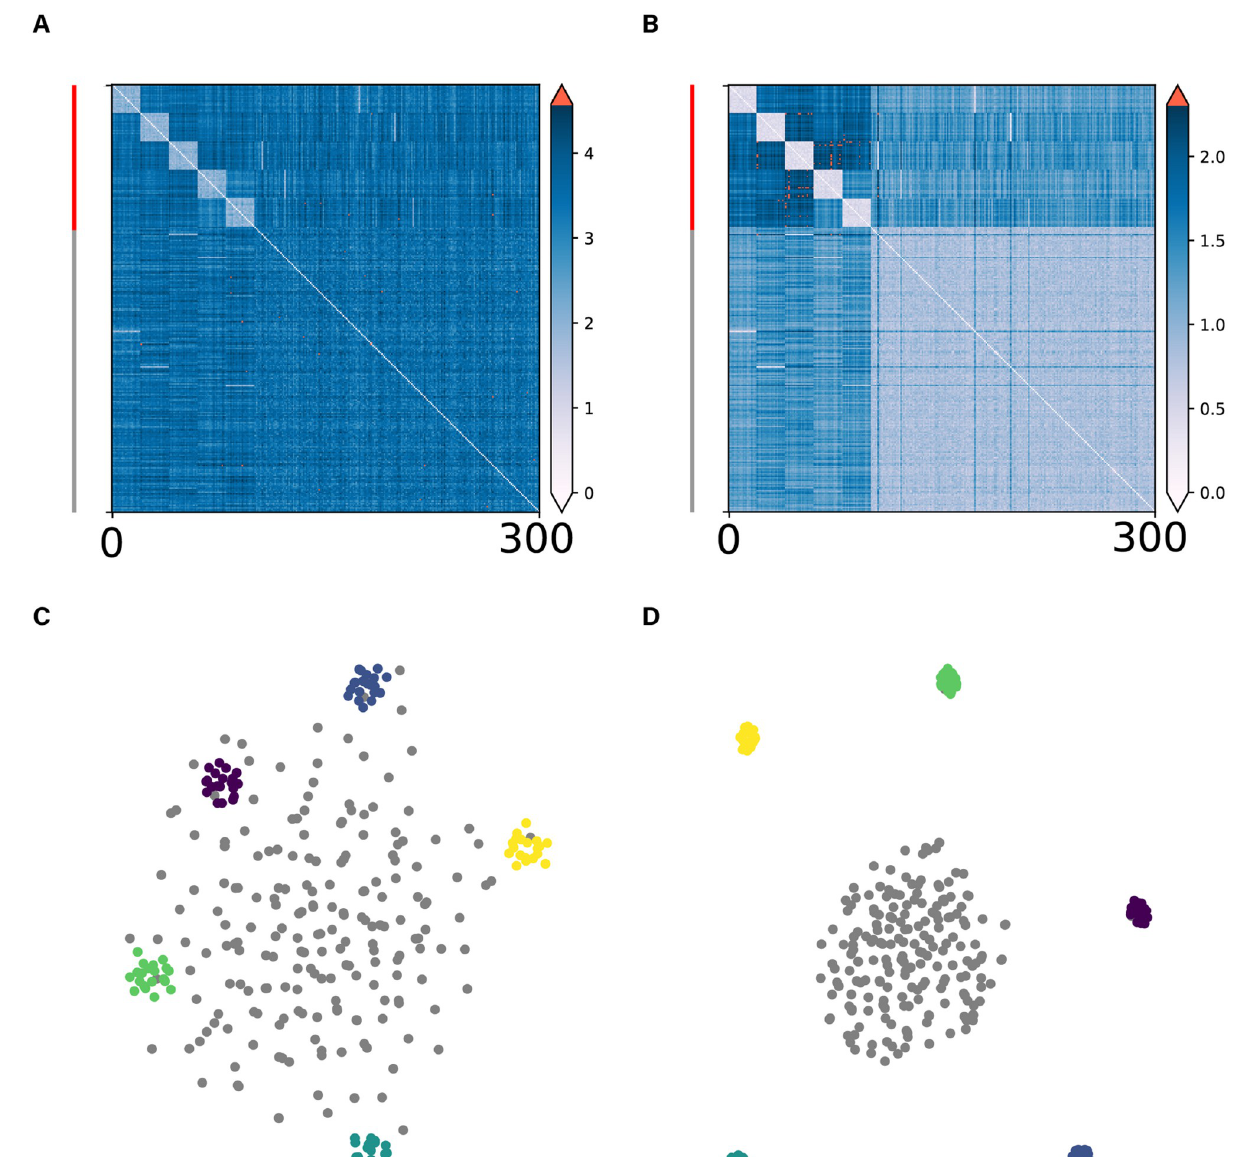
Fig 1. Scattering noise problem in t-SNE and its alleviation through the DoD transformation. In this simulation, we generated data points for five clusters and one noise cluster. For each of the five clusters, we sampled 20 points from different multivariate Gaussian distributions in a high- dimensional space ( D = 50). Another 200 noise points were sampled uniformly from the same space. A : The original Euclidean (L2) distance matrix between the data points. Data points were ordered by clusters. B : The dissimilarity matrix after the DoD transformation. We computed the distance-of- distances for all pairs of points w.r.t. their nearest 10 neighbors. Red bar on the left indicates cluster points and black bar indicates scattering noise points. C : t-SNE visualization based on the original dissimilarity matrix. D : t-SNE visualization based on the dissimilarity matrix after the DoD transformation. Points from different clusters are labelled in different colors, noise points are labelled in